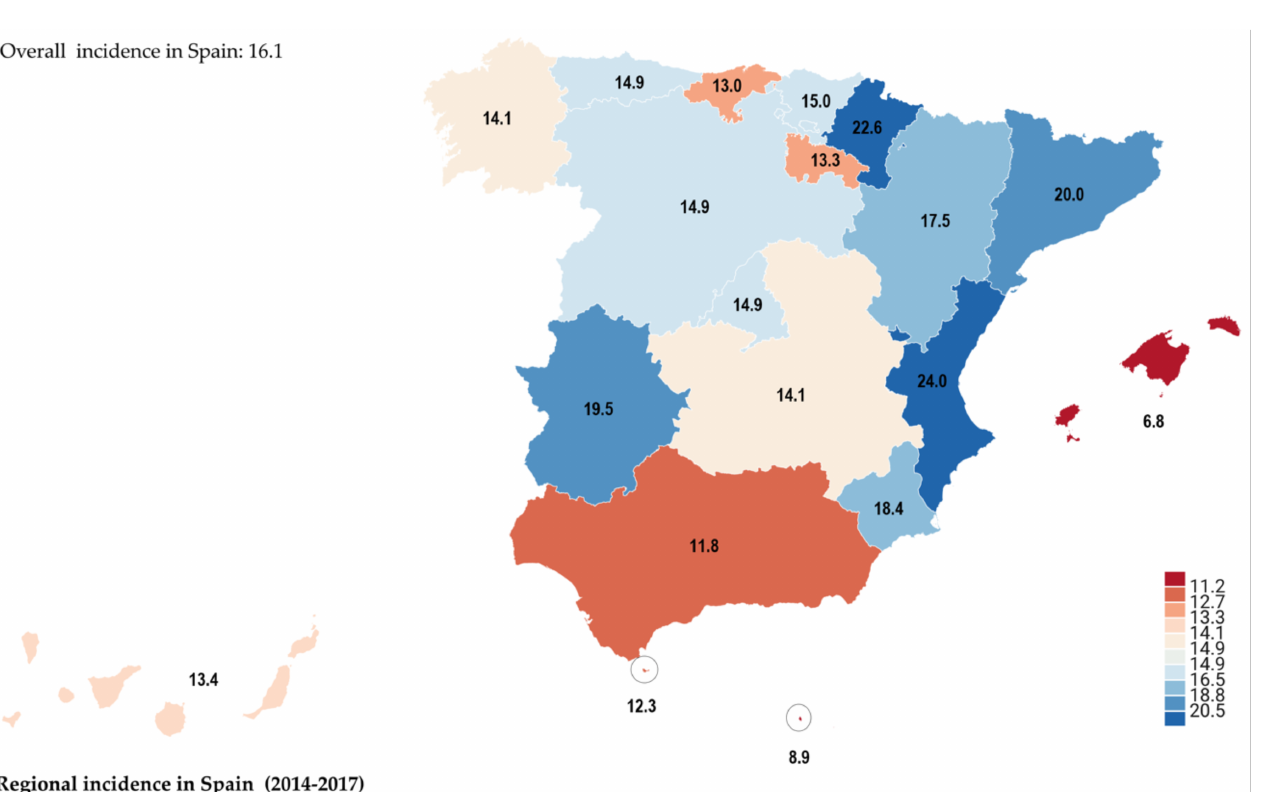
Figure 2. Incidence (cases per 10,000 women) from